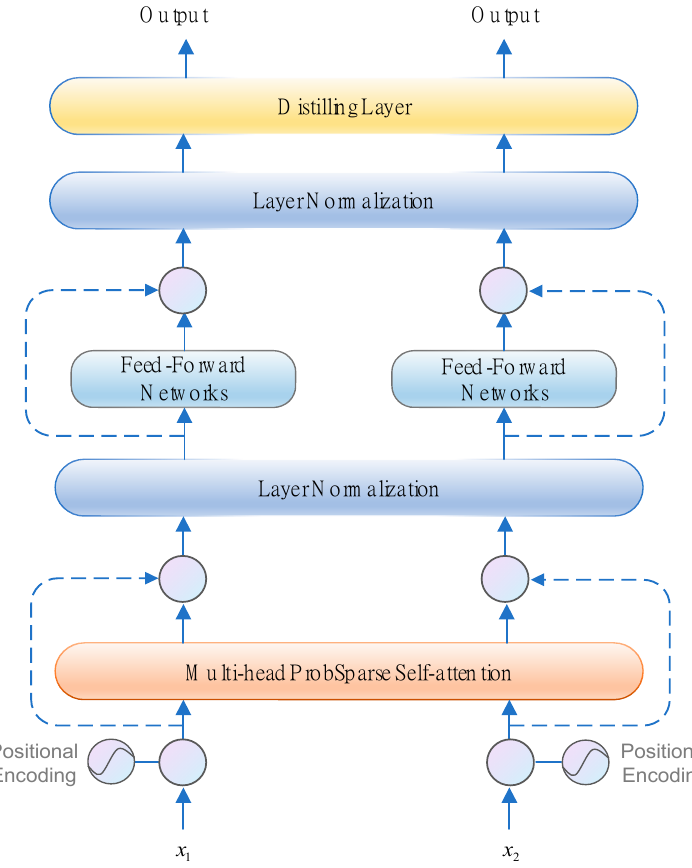
Figure 3. Illustration of the informer encoder.